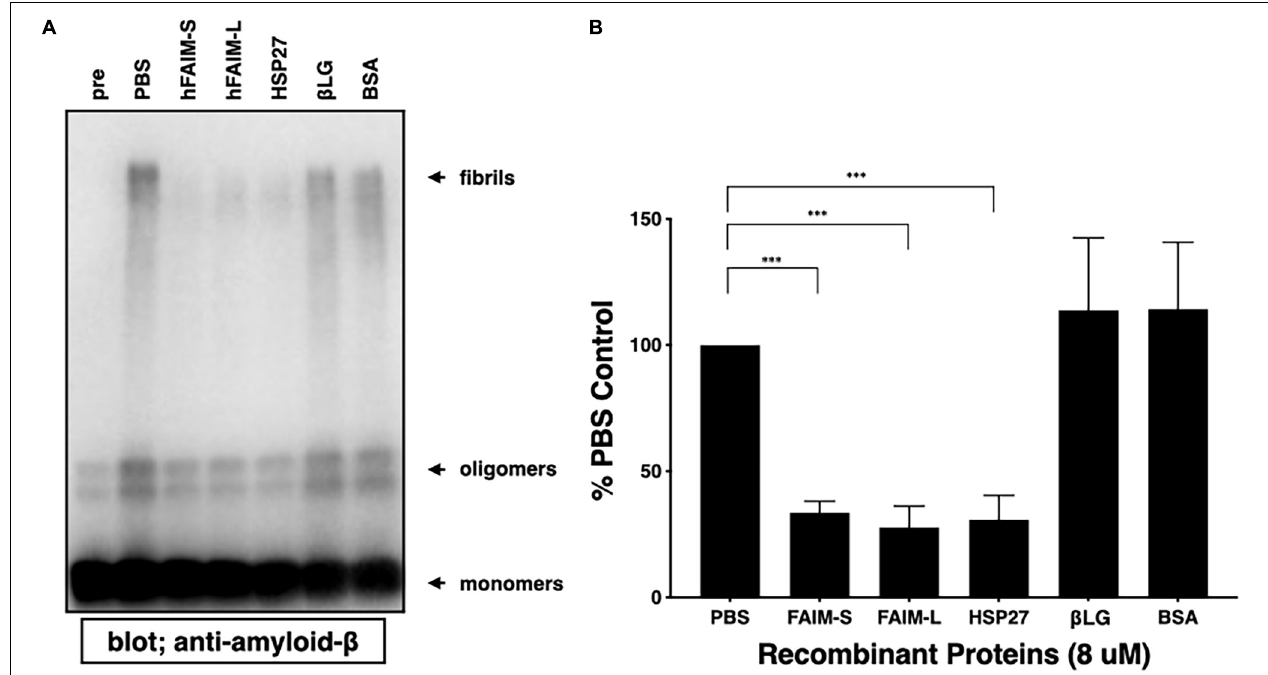
FIGURE 2 | Recombinant FAIM suppresses protein fibrillization/aggregation in a cell-free system. (A) Spontaneous oligomerization of A β (15 µ M) in vitro was induced at room temperature for 18 h in the presence of 1 µ M recombinant FAIM-S, FAIM-L, HSP27, β LG or BSA. Total samples were subjected to SDS-PAGE and western blotted for A β . Representative data from at least three independent experiments are shown. Pre: pre-incubation, PBS: buffer control. (B) The fibril levels in (A) were quantified by densitometry, and the data from three independent experiments are shown as percent of PBS control. The data are expressed as mean ± SEM. A two-tailed, unpaired Student’s t -test was used to calculate p -values. ∗∗∗ p < 0.001.